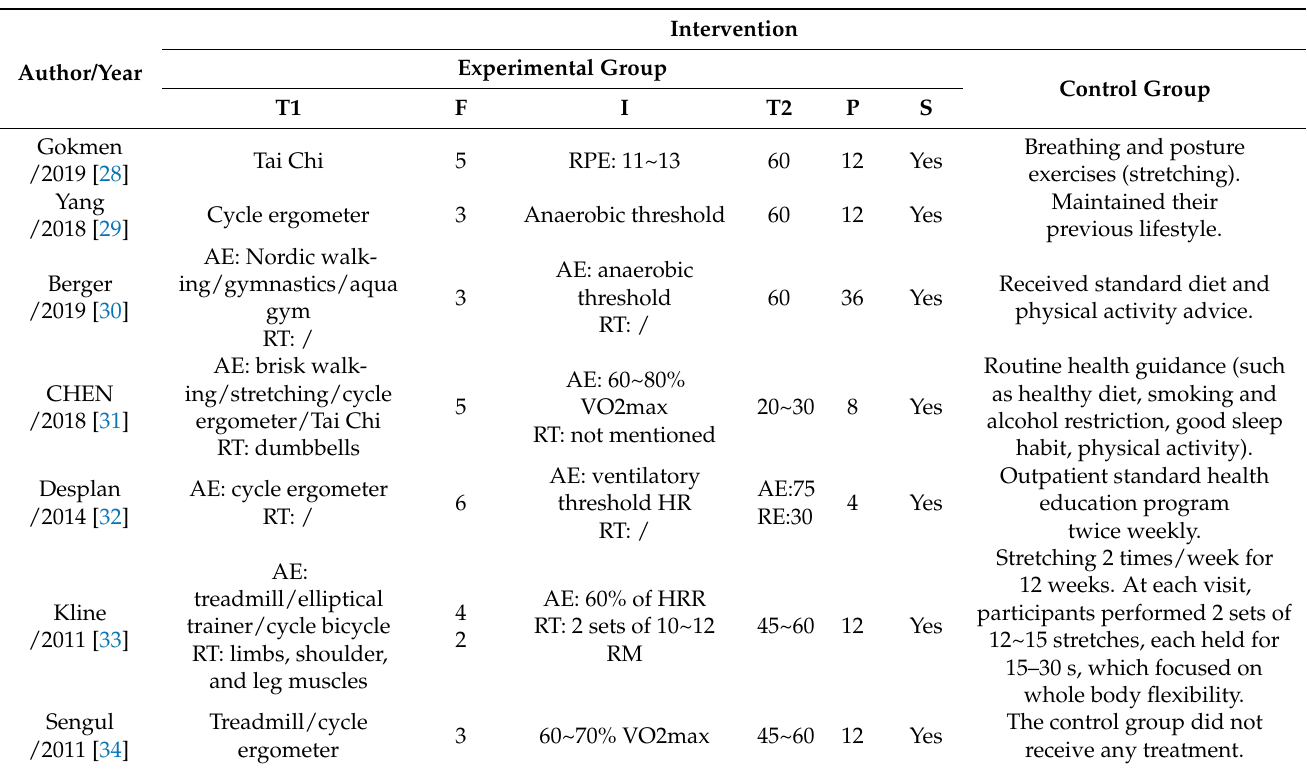
Table 4. Description of study intervention.